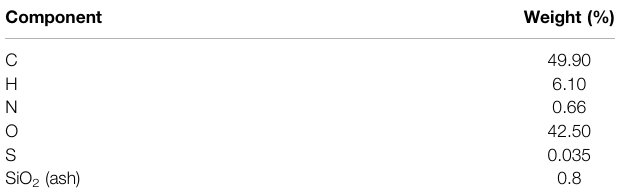
TABLE 1 | Biomass feedstock composition (dry)